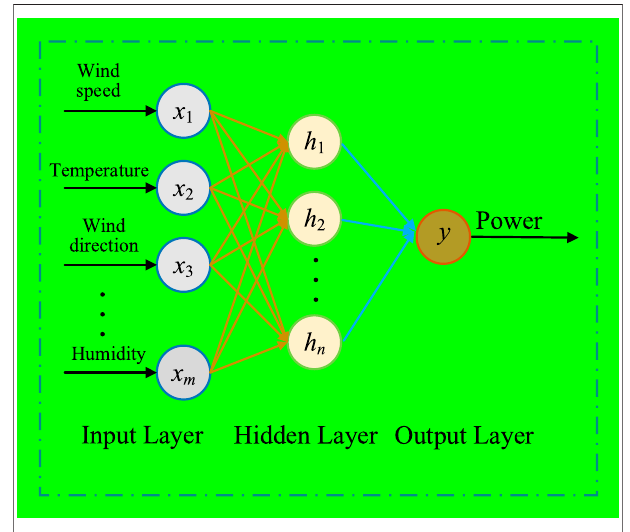
FIGURE 1 | Basic structure of the proposed BP